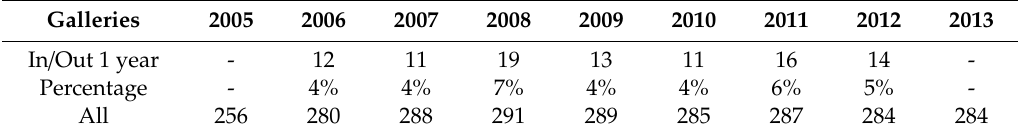
Table 2. Number of galleries admitted to Art Basel for only one